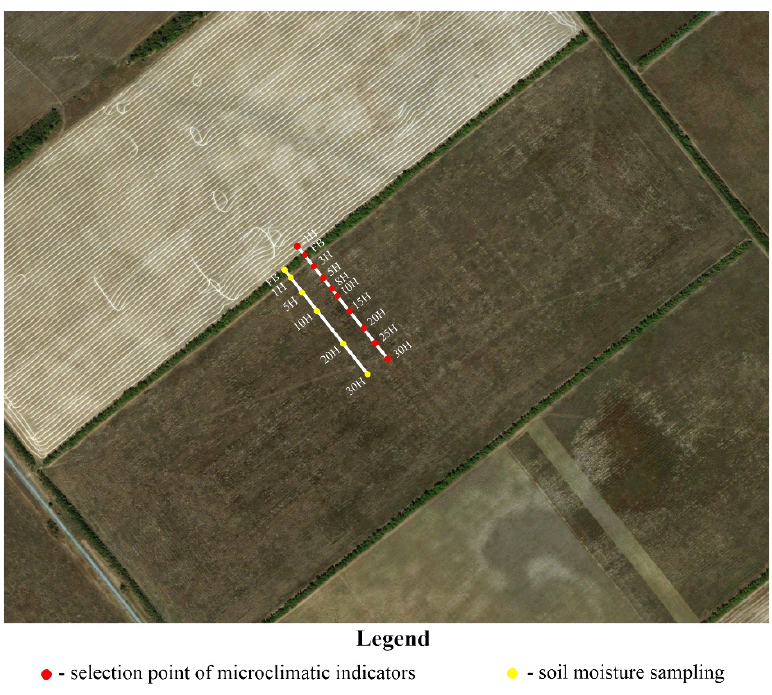
Figure 4. Soil sampling and measurement points in the investigated area.